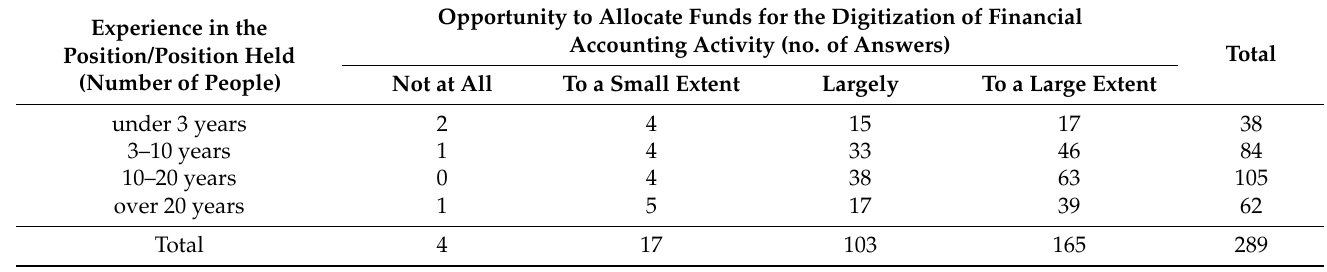
Table 10. Correlation between respondents’ experience and appreciation of the appropriateness of allocating funds for the digitization of financial accounting activity.